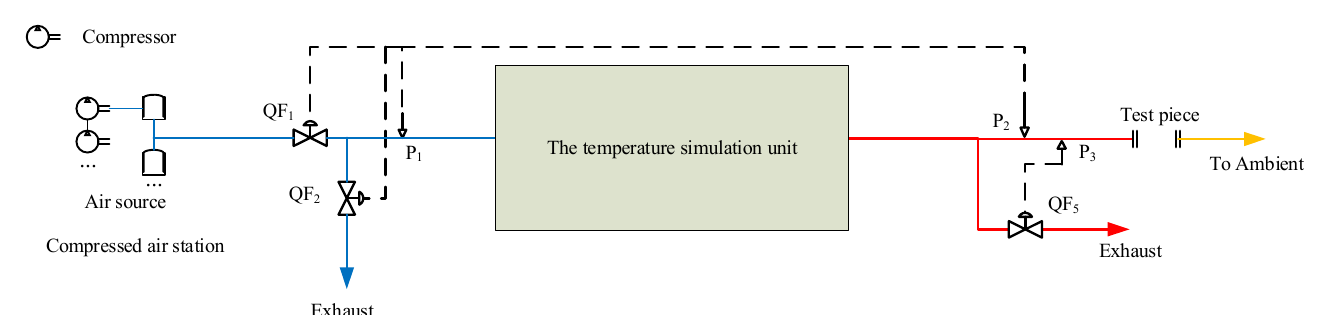
Figure 3. Rapid temperature response flow diagram.